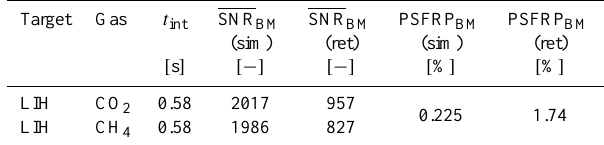
Table 4. MAMAP in-flight SWIR detector performance over inho- mogeneous land targets (LIH) for co-added burst mode. The table include the simulated and retrieved SNR of the instrument for 10 co- added burs mode (BM) measurements (column 4 and 5) and also the simulated and (from measurements) retrieved CH 4 /CO 2 PSF ratio precision (PSFRP BM ) in column 6 and